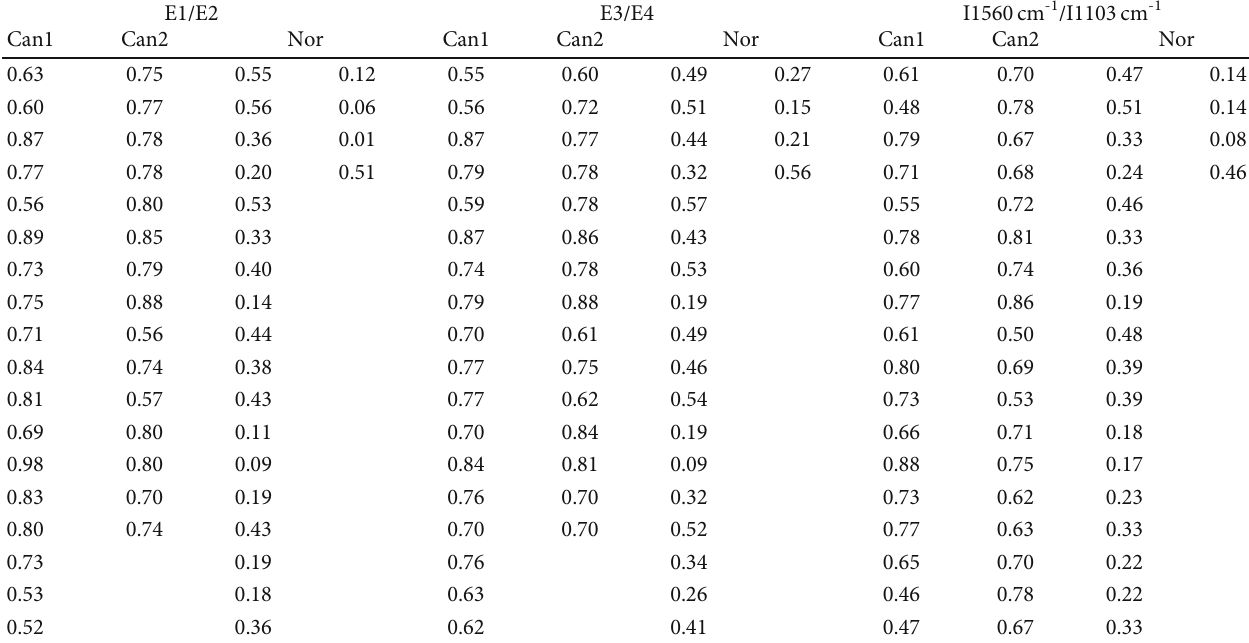
Table 2: Integral energy ratio and peak intensity ratio